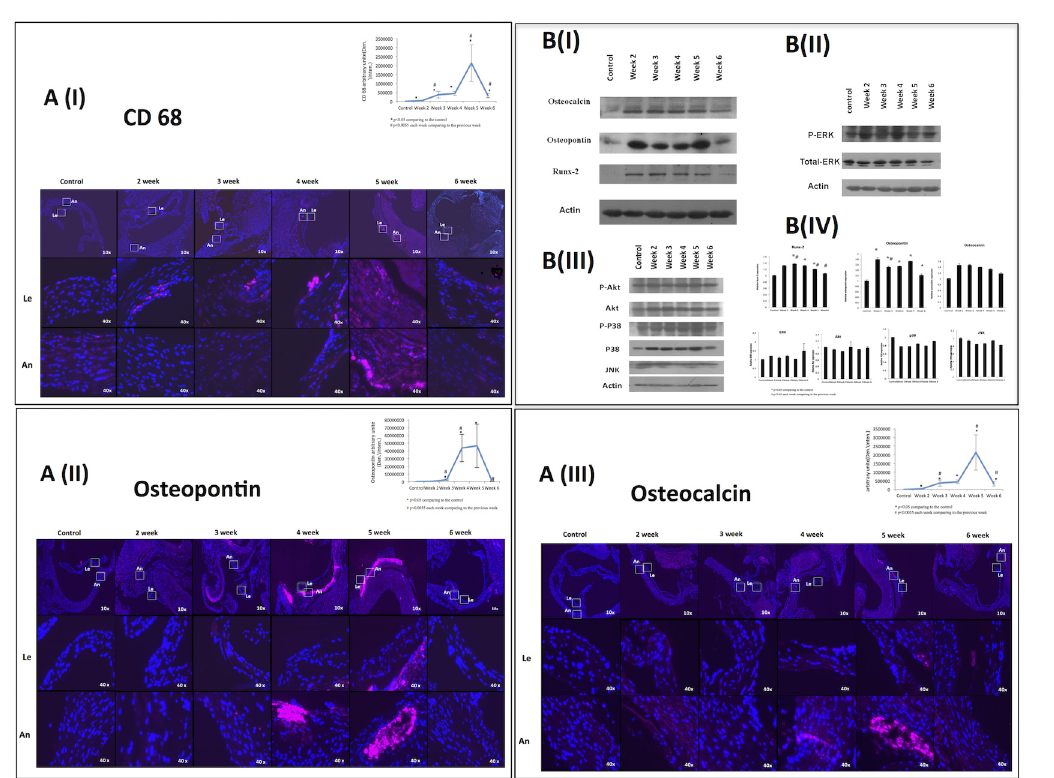
Fig 2. Macrophages osteoblast markers and intracellular pathways in early phases of calcification. (A) Immunostaining of CD68 (I), osteopontin (II), and osteocalcin (III) were positive in the valve annulus (An) and leaflets (Le) after 2 weeks on the nephropathic diet. (B) Western blot analysis (n = 3 in each group) of osteocalcin, osteopontin, and Runx-2 (I), and of the ratio of phosphorylated ERK to ERK-1(II). There were no changes in the expression Akt, JNK, or p38 pathways (III). Graphic presentation of Western blot analysis